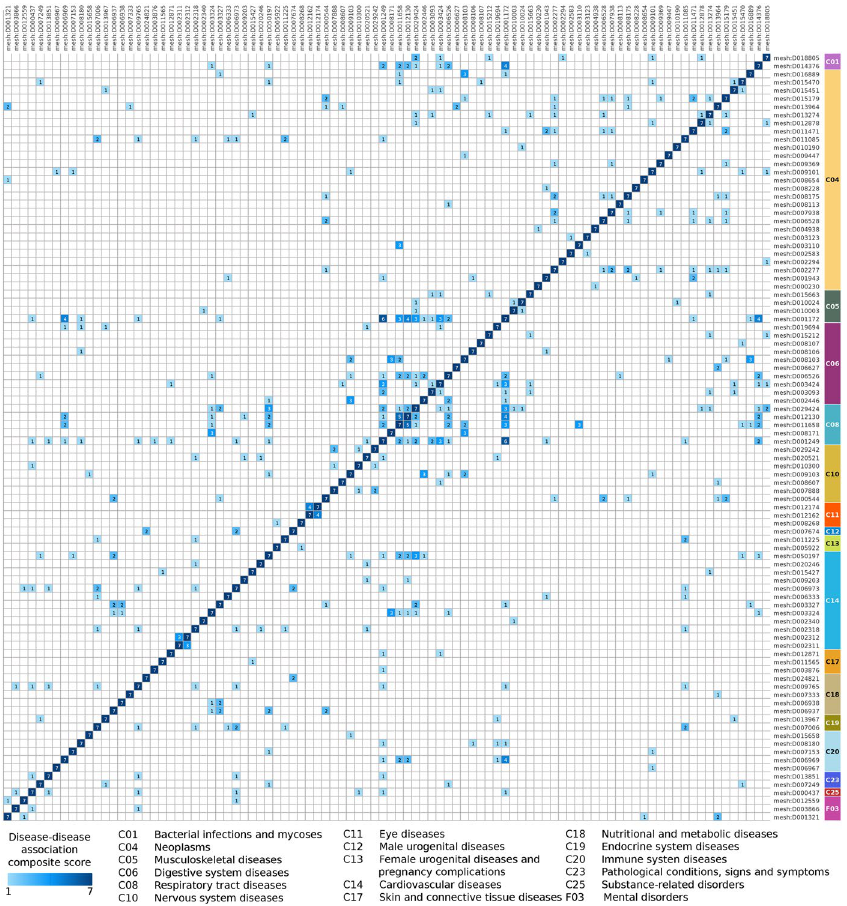
Figure 3. Heatmap of the composite score of disease-disease associations according to the strict criterion. Heatmap of the disease relationships showing the disease-disease association composite score, from 1 (pale blue) to 7 (dark blue) (see Methods for details on the score). Diseases are shown with their MeSH disease IDs (see the corresponding disease names in Table S1) and were ordered according their diseases class. Right bar of the heatmap shows the disease class where each disease belongs